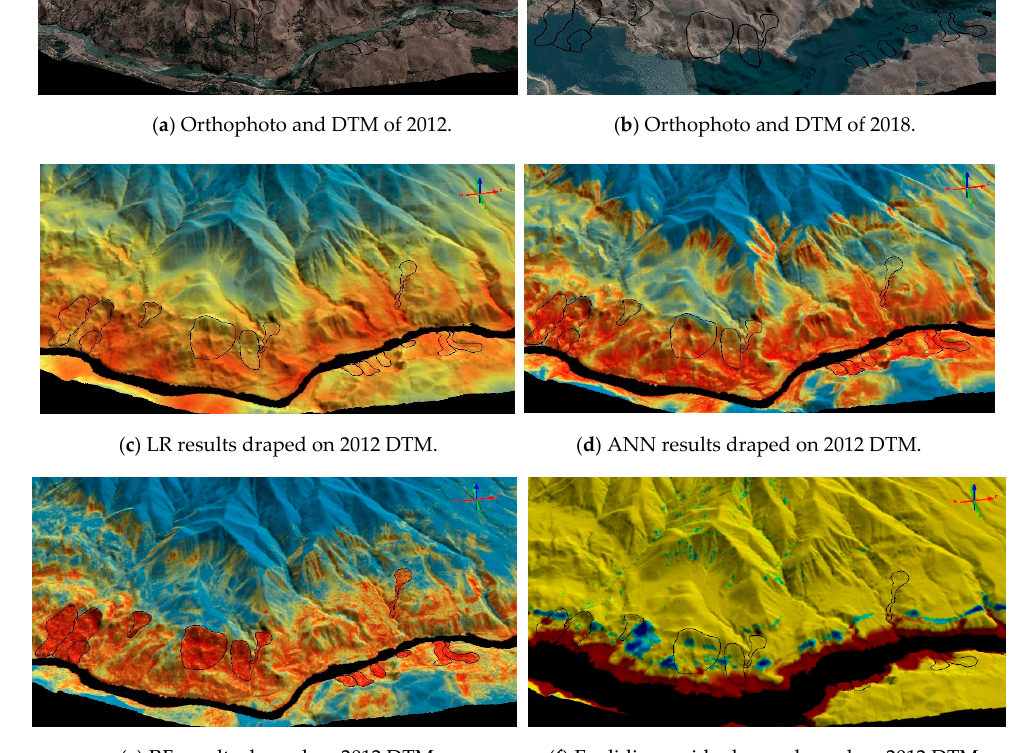
15 of 20 ( e ) RF results draped on 2012 DTM.